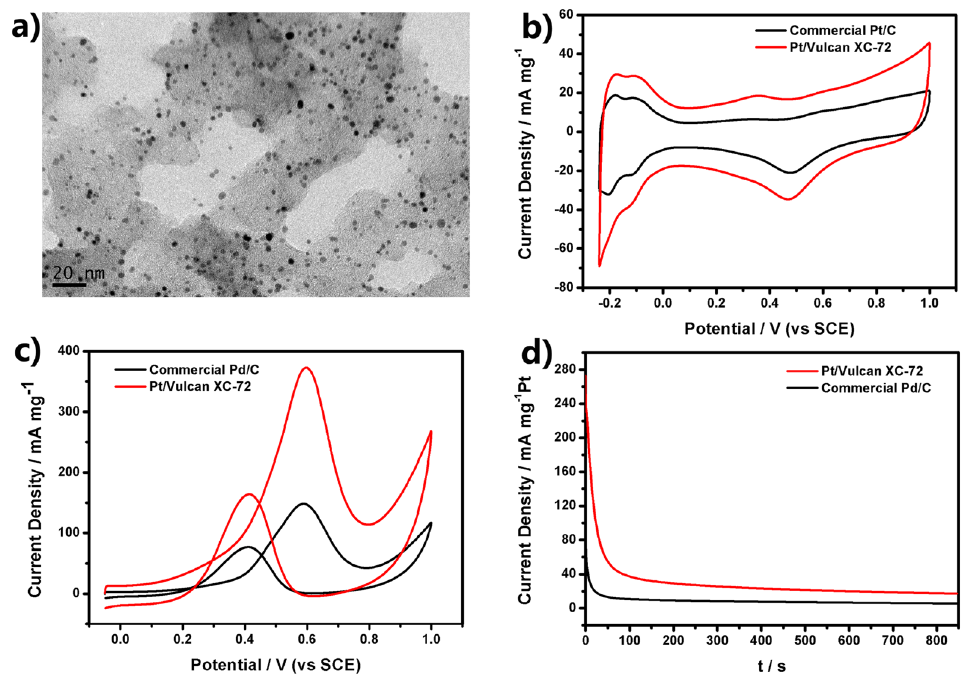
Figure 3. ( a ) TEM images of Pt ultrasmall nanoparticles (USNPs) supported on Vulcan XC-72 carbon; ( b ) Cyclic voltammetry (CV) curves of Pt electrocatalysts in N 2 -saturated 0.5 M H 2 SO 4 with a scan rate of 50 mV·s − 1 ; ( c ) CV curves at a scan rate of 50 mV·s − 1 with different Pt electrocatalysts in 0.5 M H 2 SO 4 + 0.5 M CH 3 OH; ( d ) Amperometric i - t curves of Pt electrocatalysts in 0.5 M H 2 SO 4 + 0.5 M CH 3 OH solution at 0.6 V ( vs.